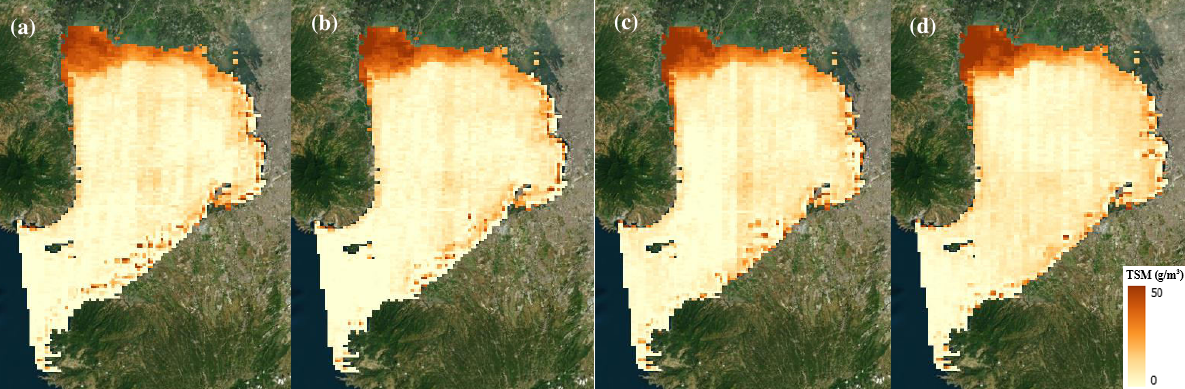
Figure 11. TSM maps for April 2, 2019 using the Dry model: (a) 9:10, (b) 9:30, (c) 9:50, and (d) 10:10 AM.